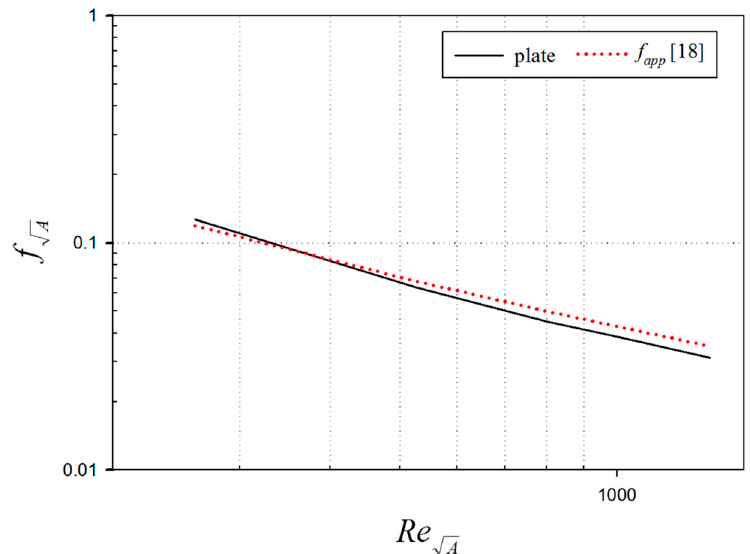
Figure 6. Friction factor vs. Reynolds number of the plain plate-fin heat sink obtained by prediction (red dashed curve) and the experiment (solid